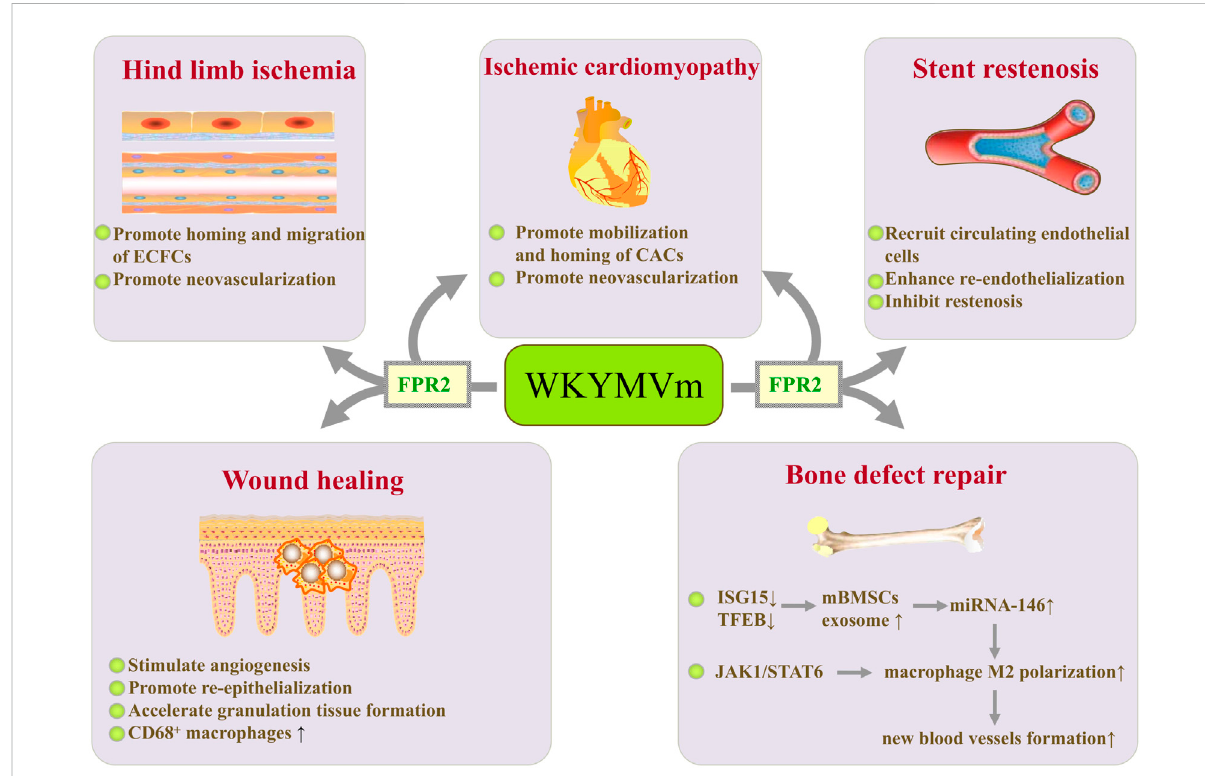
FIGURE 3 WKYMVm with angiogenesis and tissue repair. WKYMVm promotes homing and chemotactic migration of ECFCs, thereby accelerating neovascularizationinischemiclimbs.WKYMVmpromotesmobilizationandhomingofbonemarrowCACstotheischemicheart,whichisconducive to neovascularization. WKYMVm and sirolimus continuously coated bare metal stents recruits circulating endothelial cells, enhances re- endothelialization, and inhibits restenosis. WKYMVm stimulates angiogenesis, promotes re-epithelialization, accelerates granulation tissue formation, and increases the CD68 + macrophages in fi ltration in early phase during wound healing. WKYMVm reduces ISG15 and TFEB expression, increasessecretionofexosomescontainingmiRNA-146inmBMSCs,andpromotesthepolarizationofM2macrophages.M2macrophagesenhance the formation of new blood vessels to promote bone defect repair. In addition, WKYMVm polarizes macrophages into M2 phenotype by activating JAK1/STAT6 signaling pathway. ECFCs, endothelial colony-forming cells; CACs, circulating angiogenic cells; ISG15, interferon stimulated gene